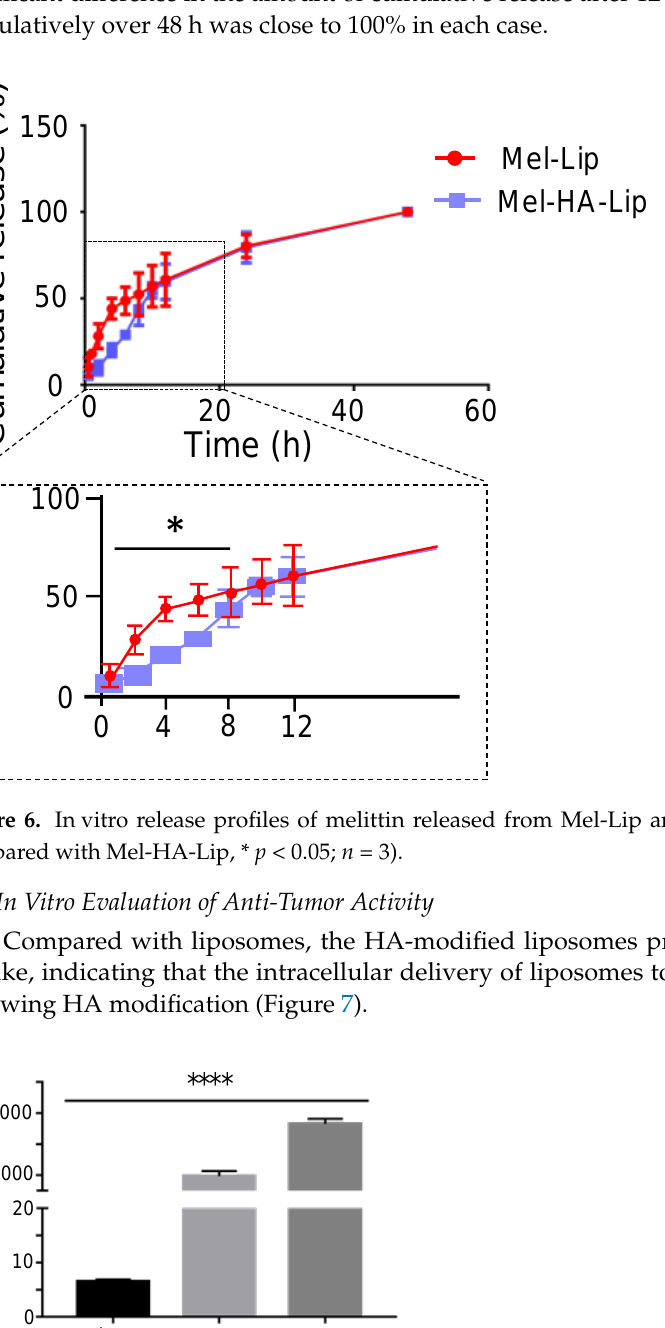
Figure 5. TEM images of Mel-Lip ( A ) and Mel-HA-Lip ( B ).